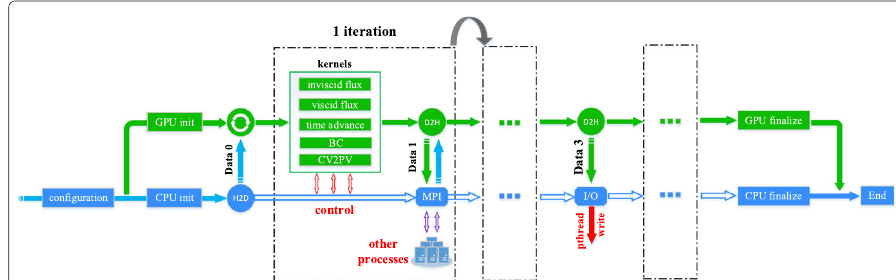
Fig. 3 A global glance of execution procedures of HiResX running on GPU. Except for initialization and data performed on CPU, all computations are performed on GPU while CPU is used to schedule kernels of GPU only. “Data 0” represents the initial data computed in CPU and uploaded to GPU. “Data 1” represents data exchanged between processes. “Data 3” represents flowfield data to be written, and it should be downloaded to CPU and written with a new